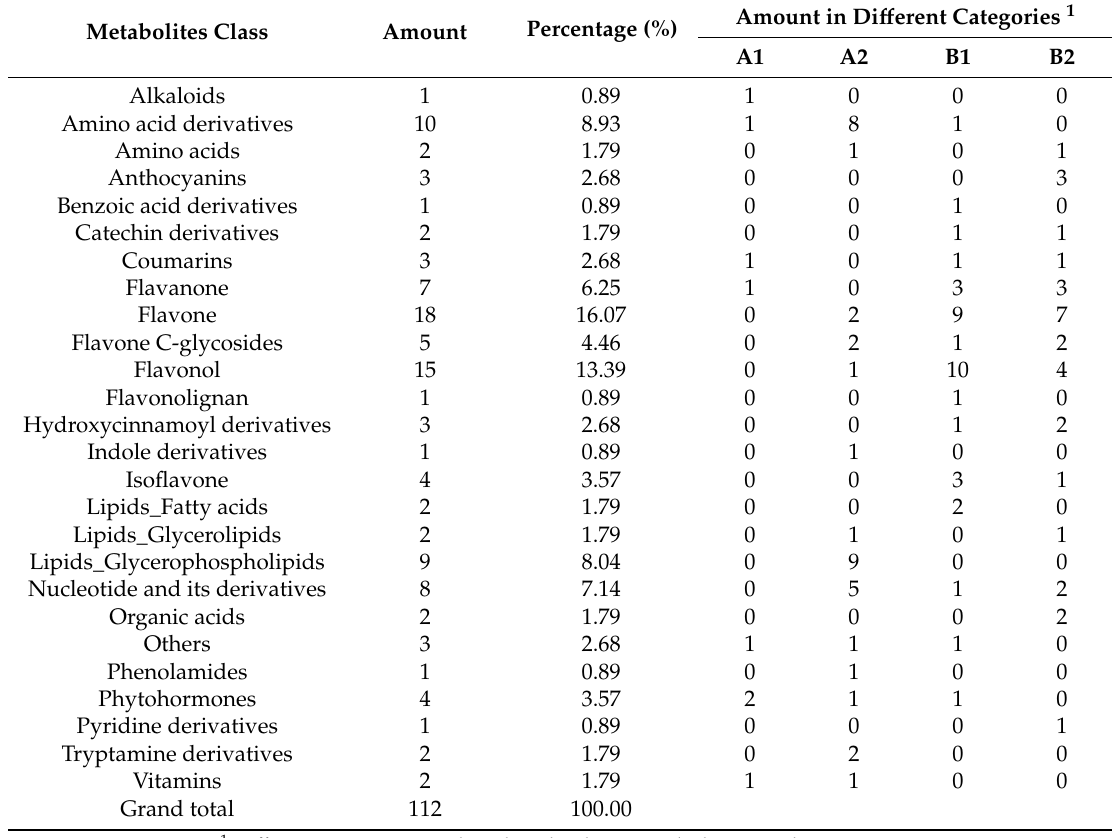
Table 1. Classification statistics of di ff erent expressive